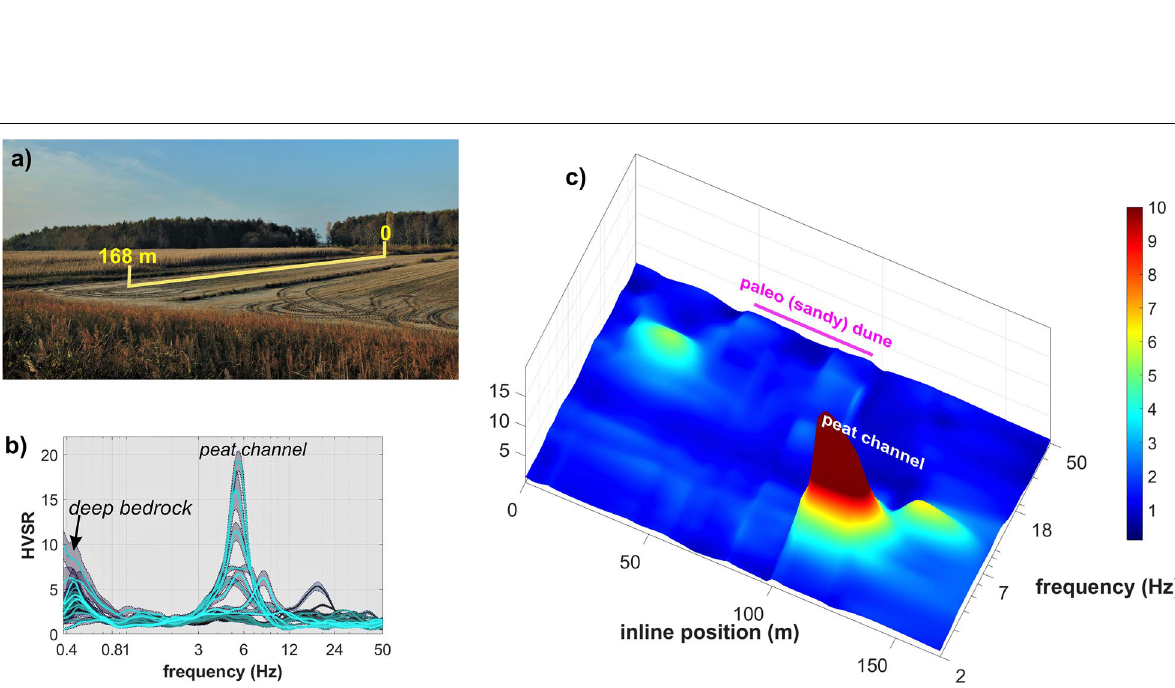
Fig. 20 2D HVSR section for the Beligna#2 residual dune: a photo of the area with highlighted the considered line (see also Fig. 19c); b HVSR curves with indicated the two characterizing peaks related to the deep bedrock and the presence of a superficial peat channel (see text); c 2D HVSR section along the investigated line according to a 3D perspective (to highlight the shallow structure, the HVSR is shown only for frequencies higher than 2